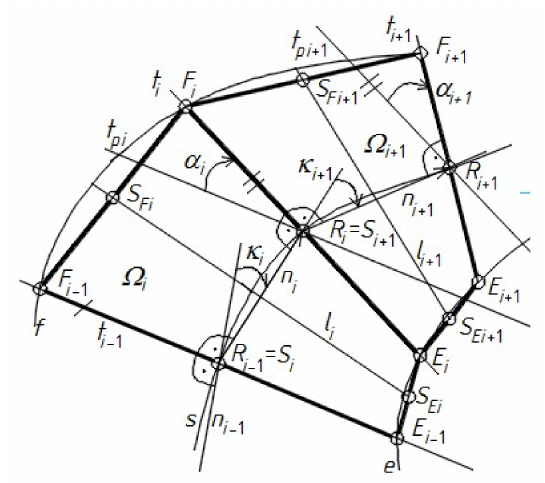
Figure 15. Shell sectors Ω i and Ω i +1 modeling two subsequent effectively transformed shell roof folds limited by pairs of skew straight lines { t i − 1 , t i } and { t i , t i +1 }, which are determined on the basis of the lines n i normal to the rulings t i and t i − 1